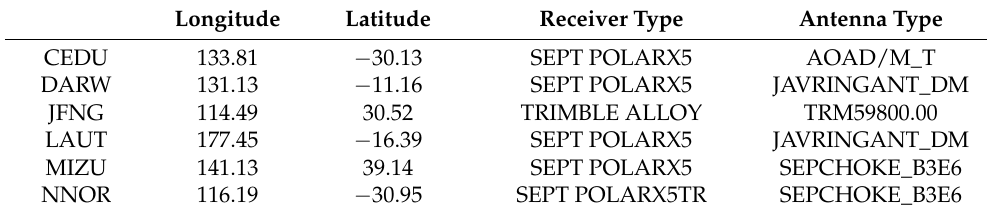
Table 2. Receiver